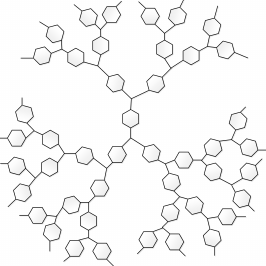
Fig. 1 The structure of 2-dimensional of dendrimer nanostar D 3 [ n ]